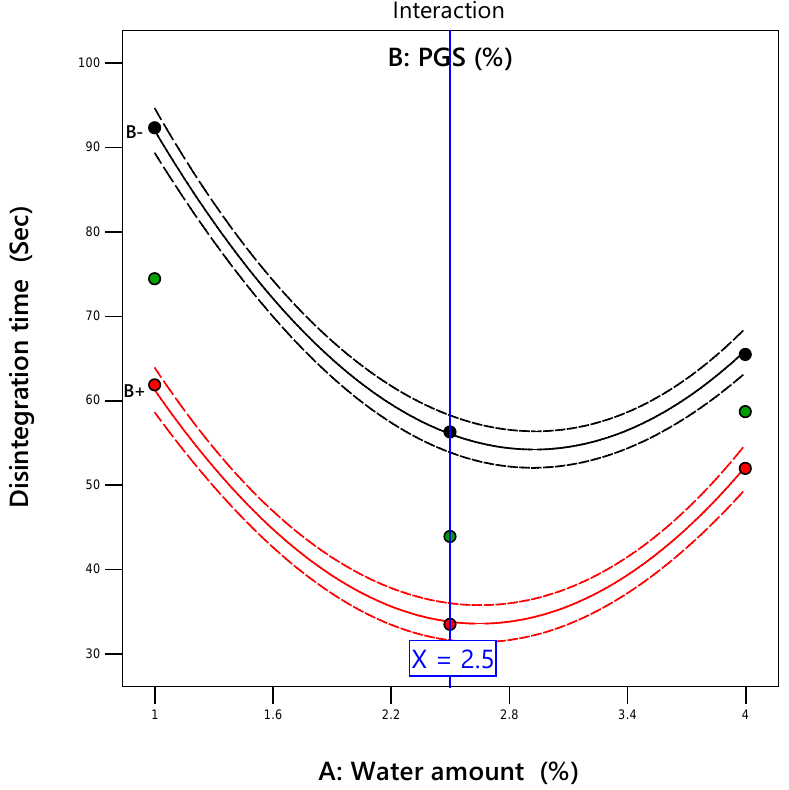
Figure 3. The interaction plot showing the influence of the water amount (X 1 ) and PGS amount (X 2 ) on in vitro disintegration time of metformin orally disintegrating tablet (ODT).